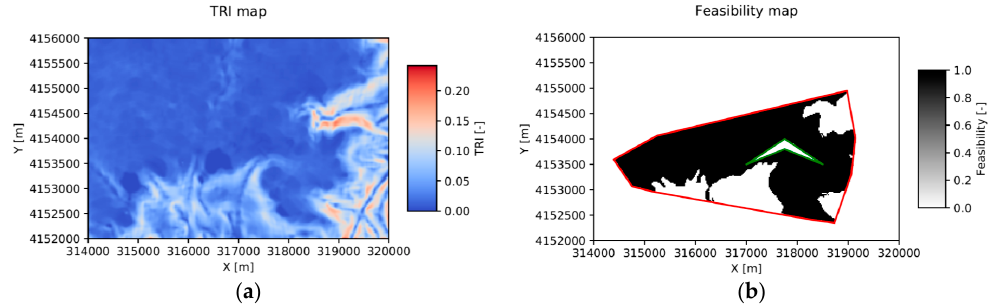
Figure 3. Constraint modelling: ( a ) TRI (terrain ruggedness index) map; ( b ) feasibility map with one inclusive (red line) and one exclusive (green line) boundary, and bounds on TRI (TRI max = 0.05 ) and (cid:1874) (cid:3040)(cid:3032)(cid:3028)(cid:3041) ( (cid:1874) (cid:3040)(cid:3036)(cid:3041)(cid:3040)(cid:3032)(cid:3028)(cid:3041) = 6.5 m/s ).